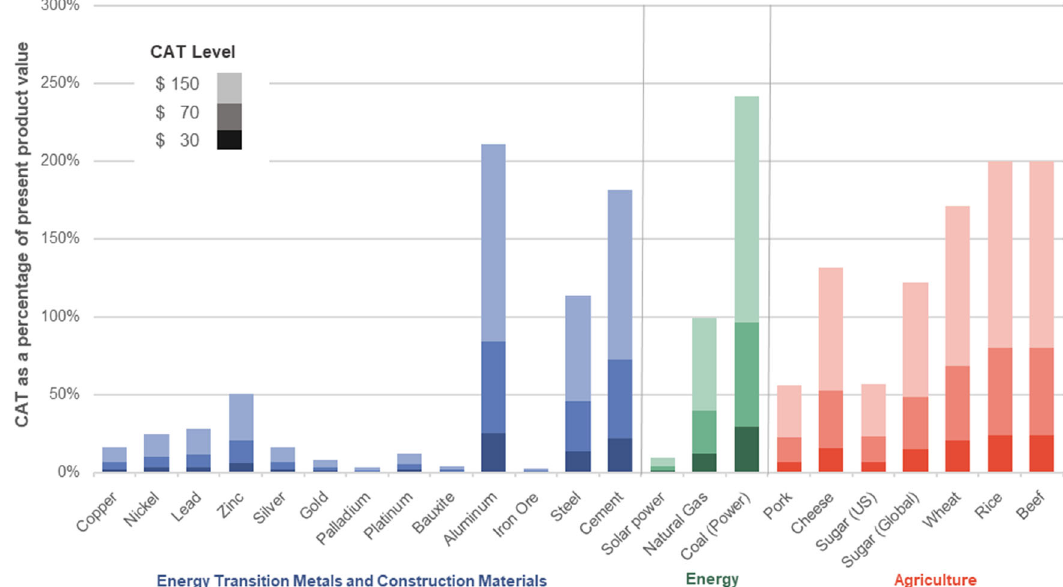
Fig. 4 Three levels of carbon taxation modeled as a percentage of present product value for selected commodities. The impact of a 30, 70, and 150 USD CAT modeled as a percentage of the present product value for selected energy transition metals and construction and smelting products (blue), energy industry commodities (green), and selected agriculture products (orange). The increasing level of carbon added taxes are shown by increasingly lighter shades, 30 USD per tonne of carbon emitted is shown in the darkest color shade, whereas 150 USD per tonne of carbon emitted is shown in the lightest color